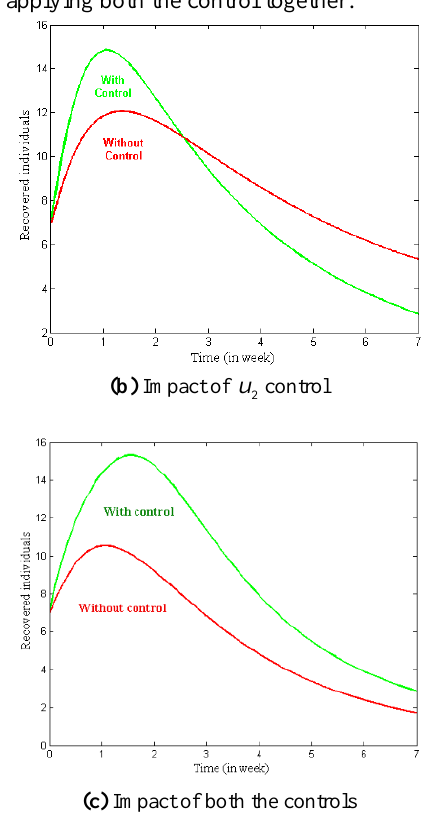
Figure 8. Impact of controls on class of recovered